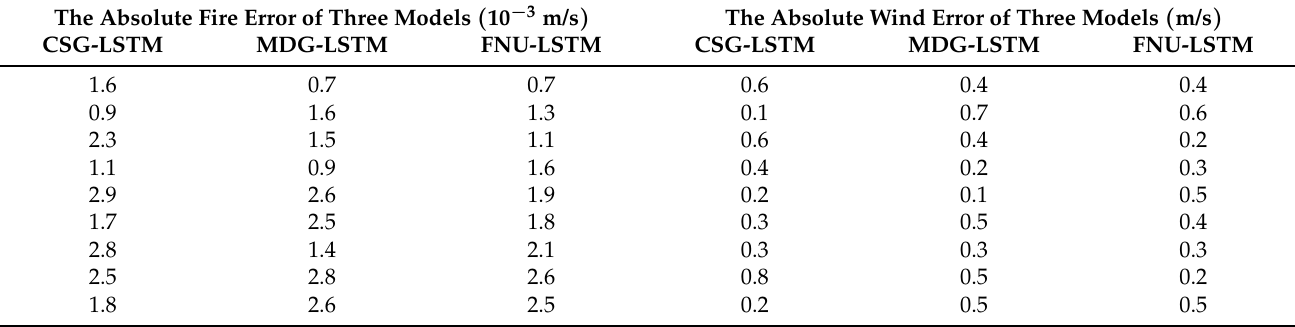
Table 4. The absolute error of three models.